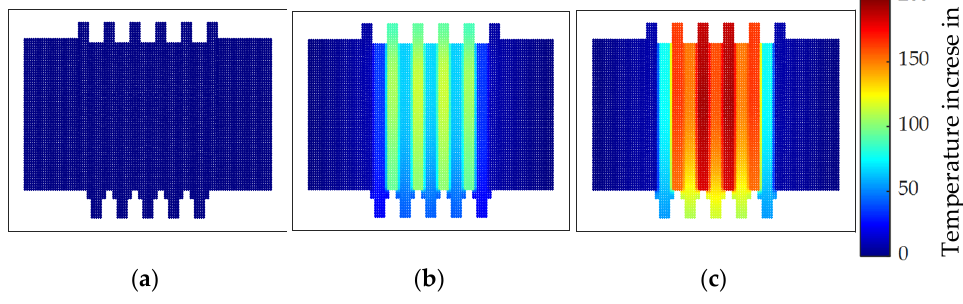
Figure 4. Exemplary curve of the axial force and differential rotational speed [20].